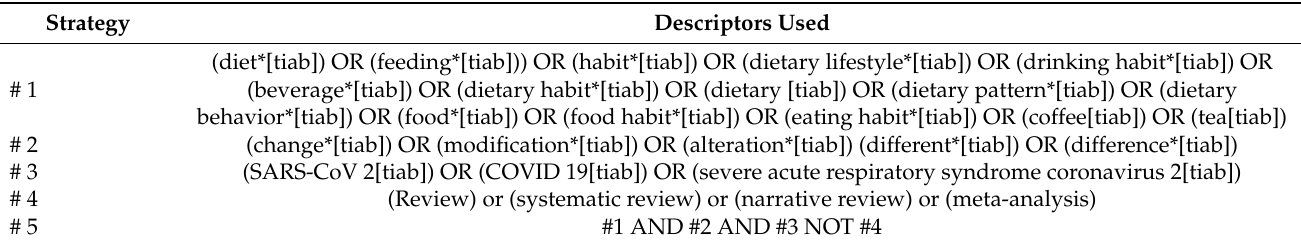
Table 1. Search strategy to be used in the US National Library of Medicine (PubMed) and Medical Literature Analysis and Retrieval System Online (MEDLINE) and adapted to the other sources, according to selected descriptors.